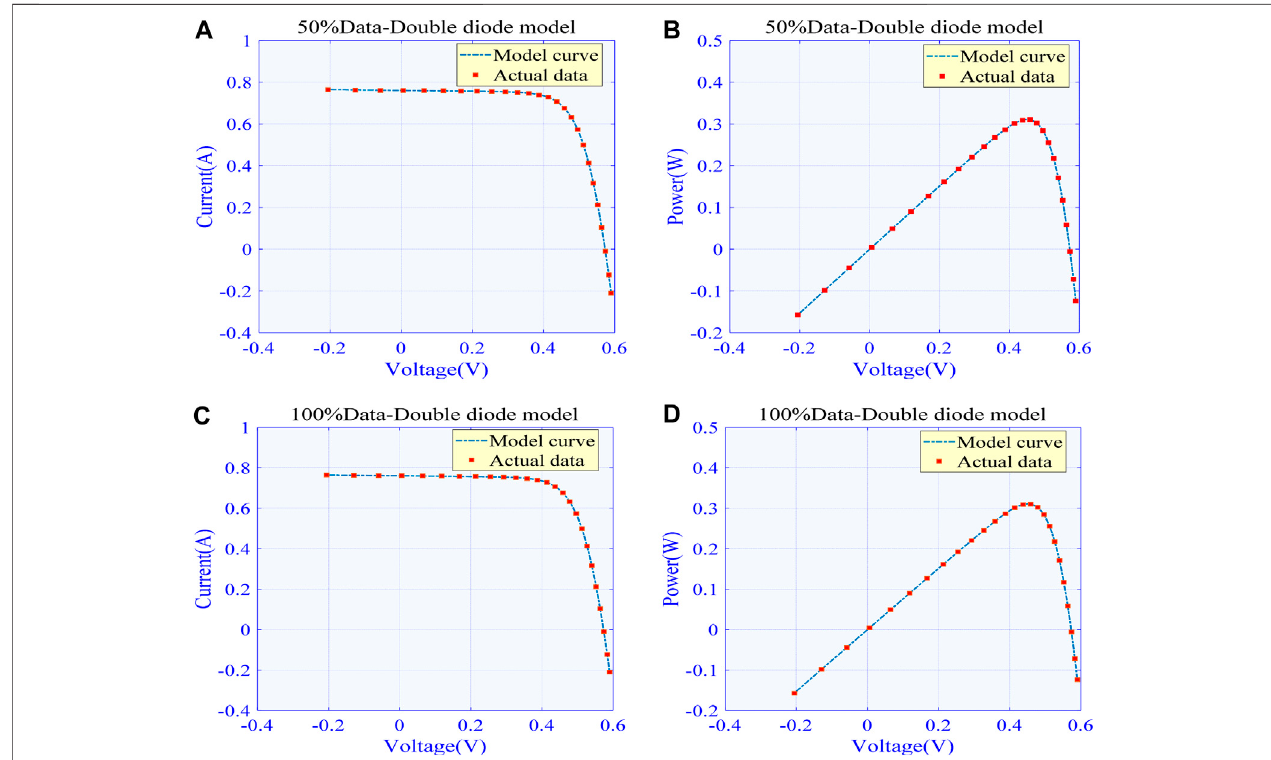
FIGURE 9 | Comparison between actual data and model curve acquired by the best algorithm in different training data for DDM: (A) I-V curve in 50% training data (B) P-V curve in 50% training data (C) I-V curve in 100% training data and (d) I-V curve in 100% training data.